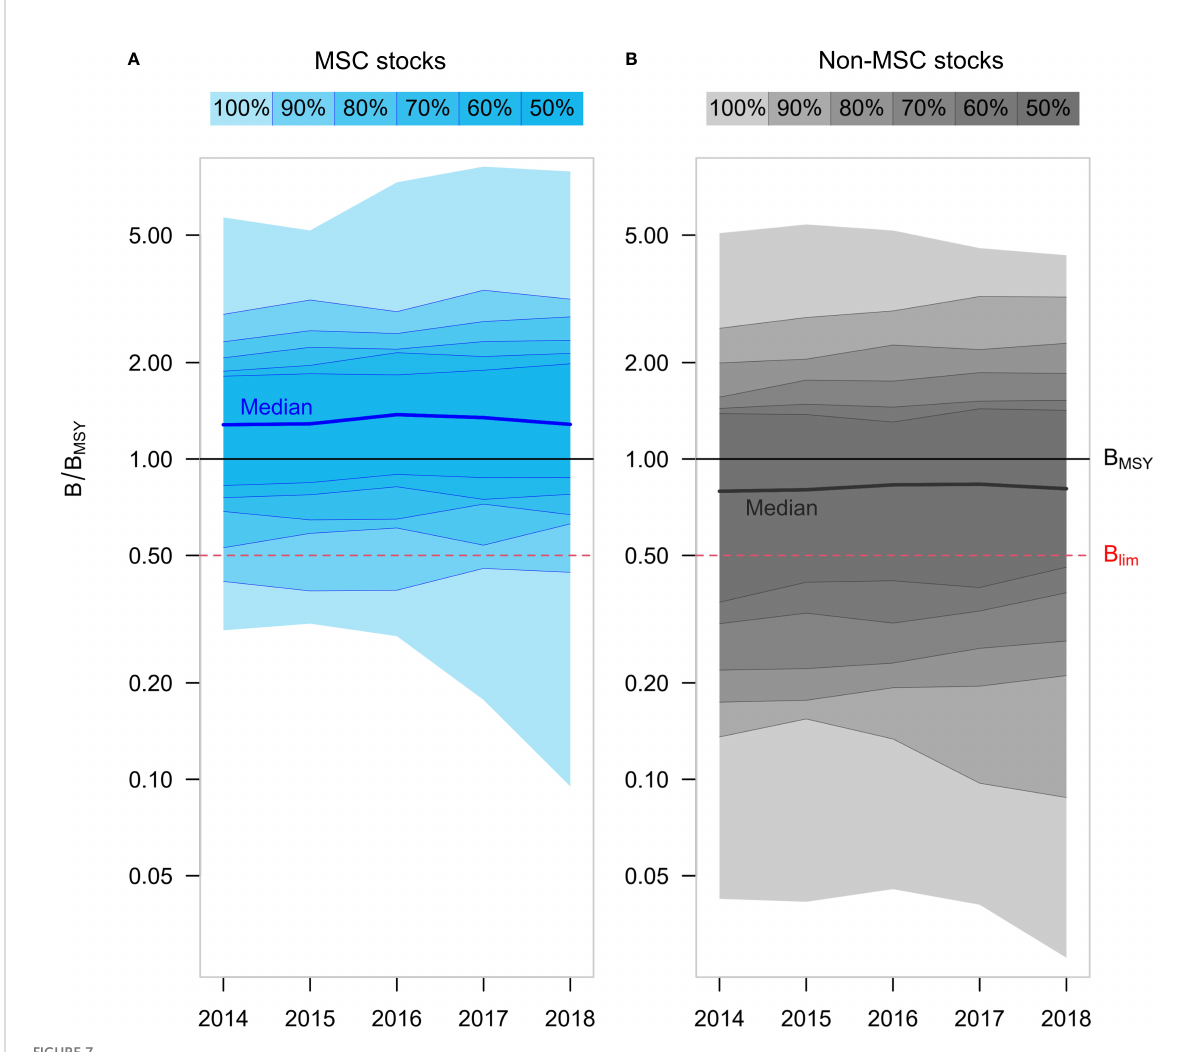
FIGURE 7 Relative biomass ( B / B MSY ) of (A) MSC stocks (n = 81) and (B) non-MSC stocks (n = 95) for years 2014-2018. B / B MSY is shown on log scale with truncated axis at lowest value. Percentiles of the distributions across stocks in each group are shown by successive shading levels; 100% intervals represent the full range, and 50% intervals range from the 25 th to the 75 th percentiles across stocks. Median values are overlaid. Target ( B MSY ) and limit ( B lim ) reference point thresholds are shown for